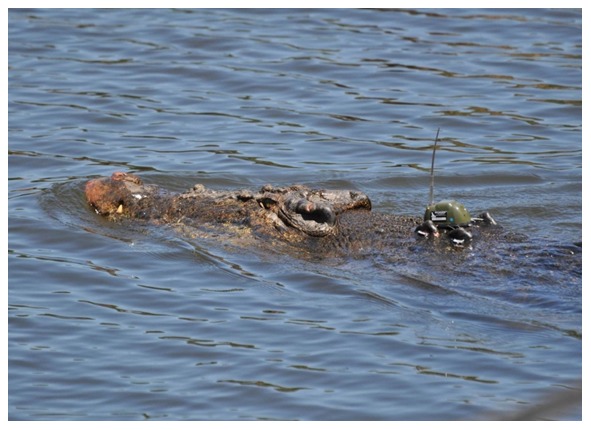

Crocodylus porosus with GPS-based satellite transmitter attached to the nuchal rosette.